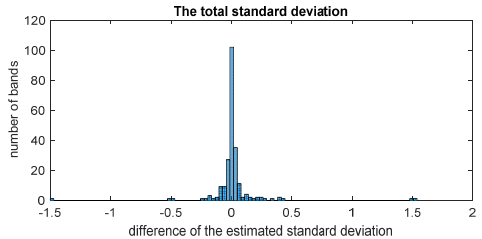
Figure 20. The total standard deviation σ T Wavelet+MLR.